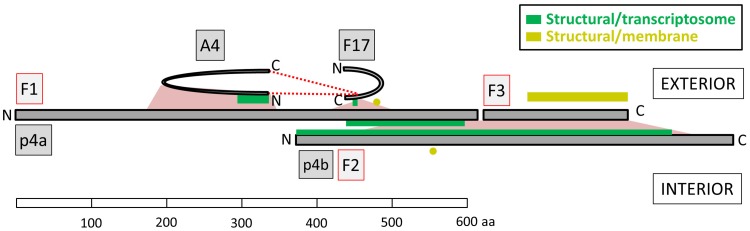
Simplest arrangement satisfying topological restraints between structural proteins p4a, p4b, A4, and F17.‘N’, ‘C’, ‘F1’, ‘F3’, ‘F2’ refer, respectively, to protein N- and C-termini, proteolytic fragments 1 and 3 of p4a and fragment 2 of p4b. p4a-fragment 2 and p4b-fragment 1 have been discarded. Pink trapezoids: The p4a/p4b and p4a/A4 interaction regions (from Fig 5a). Pink wedge: The F17(K74)/p4a interaction region (from Fig 5d). Broken red lines: XL from F17(K74) to both ends of protein A4 (from S1 Fig). The arrangement shown also emphasizes the absence of p4b interaction with either A4 or F17 and the absence of any interactions within the four-protein complex of protein A4’s C-terminal half or p4a’s N-terminal region (Fig 5a and 5d). Also accounted for are the three-domain structure of protein A4 (Fig 5c) and a core-wall exterior location for A4 as predicted by immunoEM studies ([7, 8]). Among the membrane proteins, interaction sites for J5, A21, H3, A16, G3, A26 and ATI cluster at the C-terminal region of p4a (yellow line) while A17 interacts further upstream, with p4a fragment 1 (yellow circle; from S1 Fig). p4b’s only interaction with a bona fide membrane protein is with A17 (yellow circle; from S1 Fig). This membrane protein arrangement suggests that p4b may be oriented towards the interior of the core. Green lines: Regions of structural proteins that interact with transcriptosome components (from S1 Fig). These presumably extend into the third dimension.